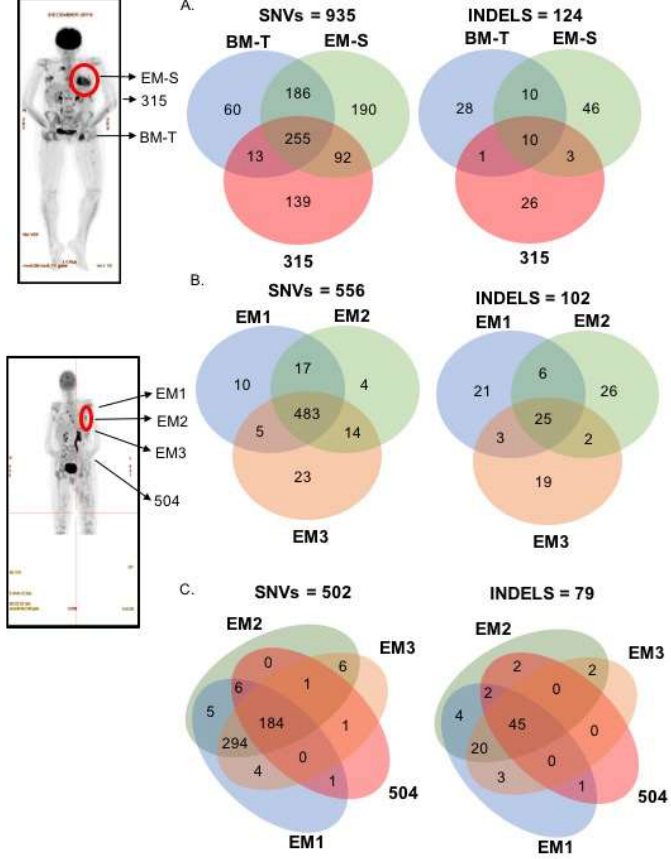
Figure 2. Spatial genetic heterogeneity. Spatial genomic heterogeneity was evident in comparisons of EM-tissues, BM biopsy and ctDNA ( A ) Left and right venn diagrams indicates the presence of common and exclusive SNV and INDELS, respectively, in time-matched EM-S, BM-T and 315 ( B ) Left and right venn diagrams indicates the presence of common and exclusive SNV and INDELS, respectively, in an axillary EM-plasmacytoma biopsied at three locations (EM1, 2 and 3) ( C ) Left and right venn diagrams indicates the presence of common and exclusive SNV and INDELS, respectively, in time-matched EM-plasmacytoma biopsied at three locations (EM1, 2 and 3) and ctDNA sample 504. Red circles on PET image indicate the areas of EM-tissue